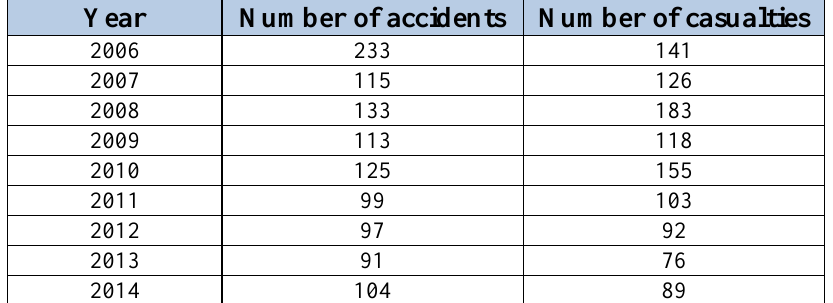
Table 1 Number of rail accidents in the Czech Republic and number of relevant casualties